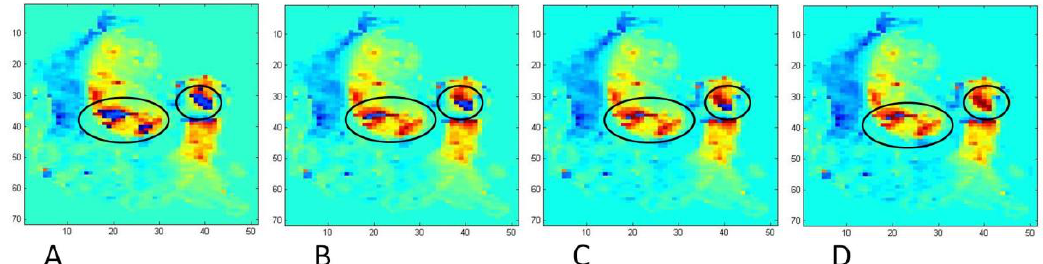
Figure 2. Results of the anti-aliasing algorithm on aliased image slices of the aorta and main pulmonary artery (MPA) demonstrating the first, second, third, and fifth iterations of the algorithm on a heavily aliased velocity image. Initially aliased areas are circled in black. No further aliasing is identified by the algorithm beyond the fifth iteration (panel D) and the code terminates, leaving panel D as the final corrected image.